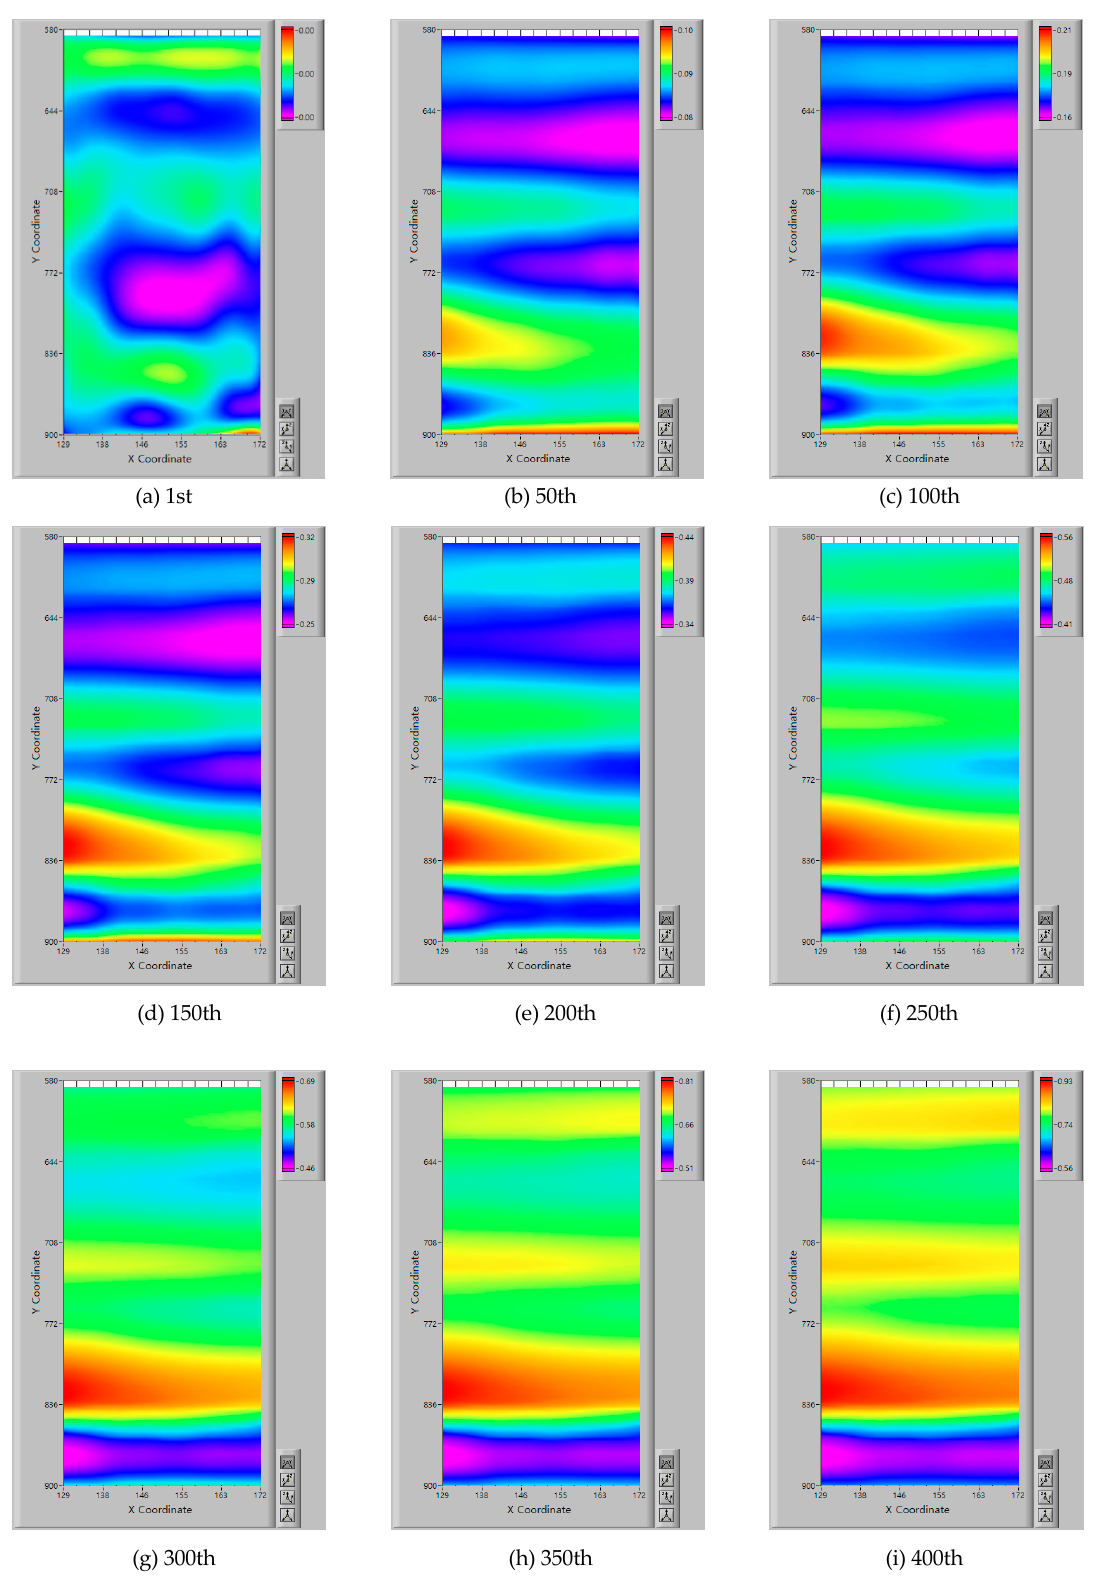
Figure 17. Y-direction strain distributions from DIC measurement.